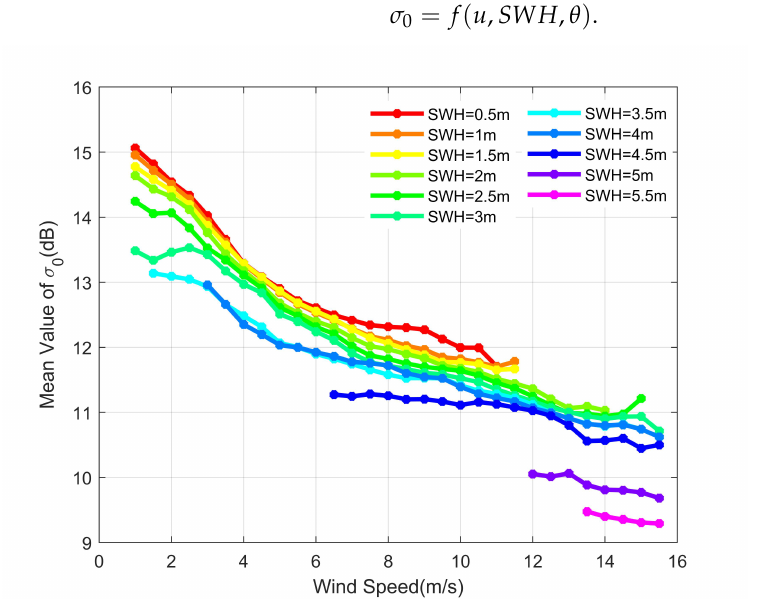
Figure 4. Mean values of σ 0 at different wind speeds and SWHs at 5° incidence angle. Different colored curves represent different SWH